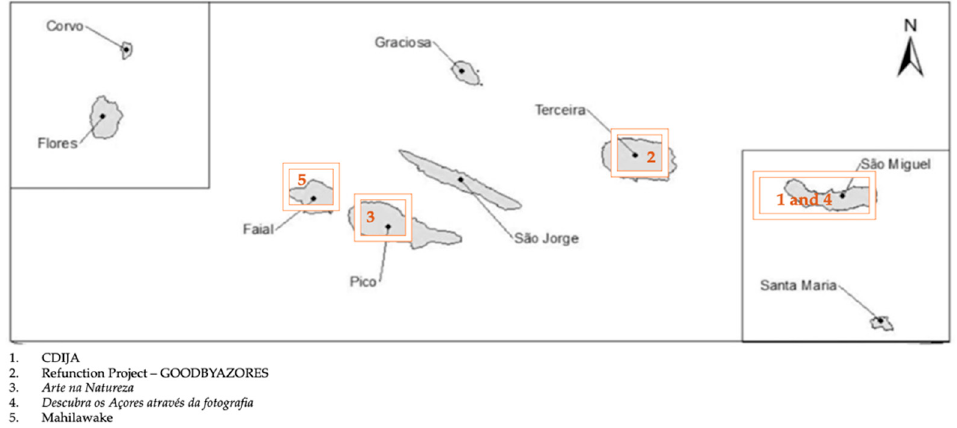
Figure 1. Location of the Azorean creative pilot projects.